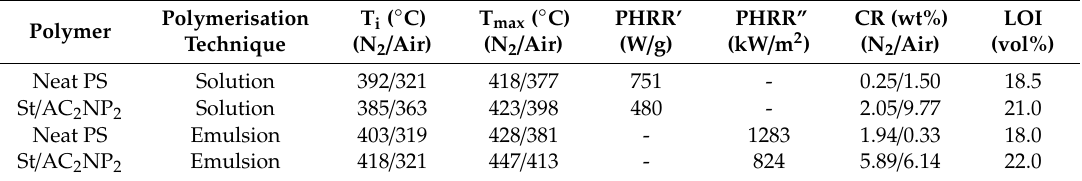
Table 2. Flammability data for PS and St/AC 2 NP 2 copolymer prepared by different polymerisation